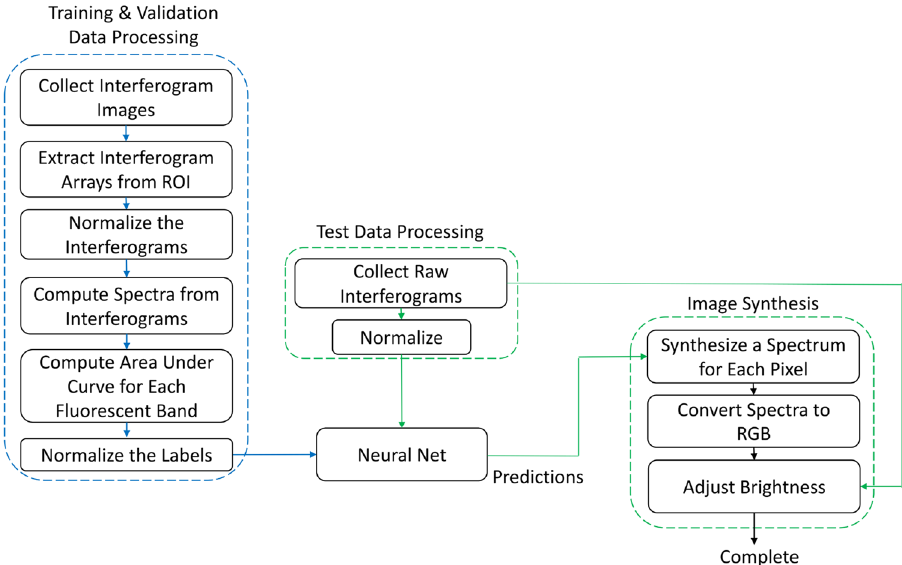
Figure 2. Data processing flowchart starting with collected interferogram images. Training data is processed by computing the spectra, and finding the area under the curve of each fluorescence emission band. The neural network is trained, and then used to predict and synthesize an image from an unknown sample. Training process is shown in blue, while the testing process is shown in green. Validation process followed training process except with a sample which was not trained on. Created with Microsoft PowerPoint ver. 2111 Build 14701.20262 (https:// produ cts. office. com/ en- us/ power point).